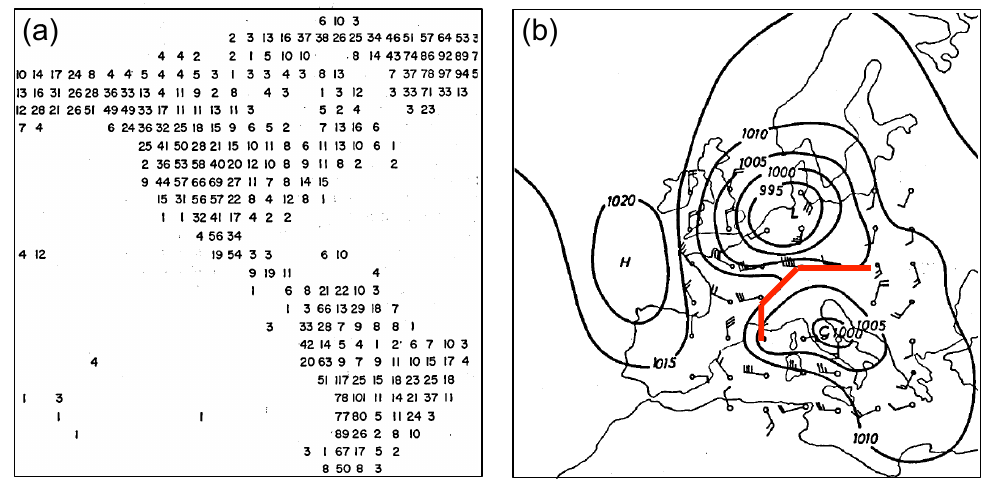
Figure 10. Historical papers on topography in atmospheric models. ( a ) Section of a table showing the hand-digitized topography of North America at a resolution of 5 degrees latitude and longitude from [152]. The data are tabulated in units of 100feet. ( b ) Surface pressure in an early simulation of Alpine Lee Cyclogenesis from [156], with the red line indicating the wall TABLE 1. T ADULATED AVERAGED HEIGHTS AT FIVE-DEGREE LATITUDE-LONGITUDE iNTERSECTIONS, FOR WESTERN HEMISPHERE. Heights are in hundreds of feet. '